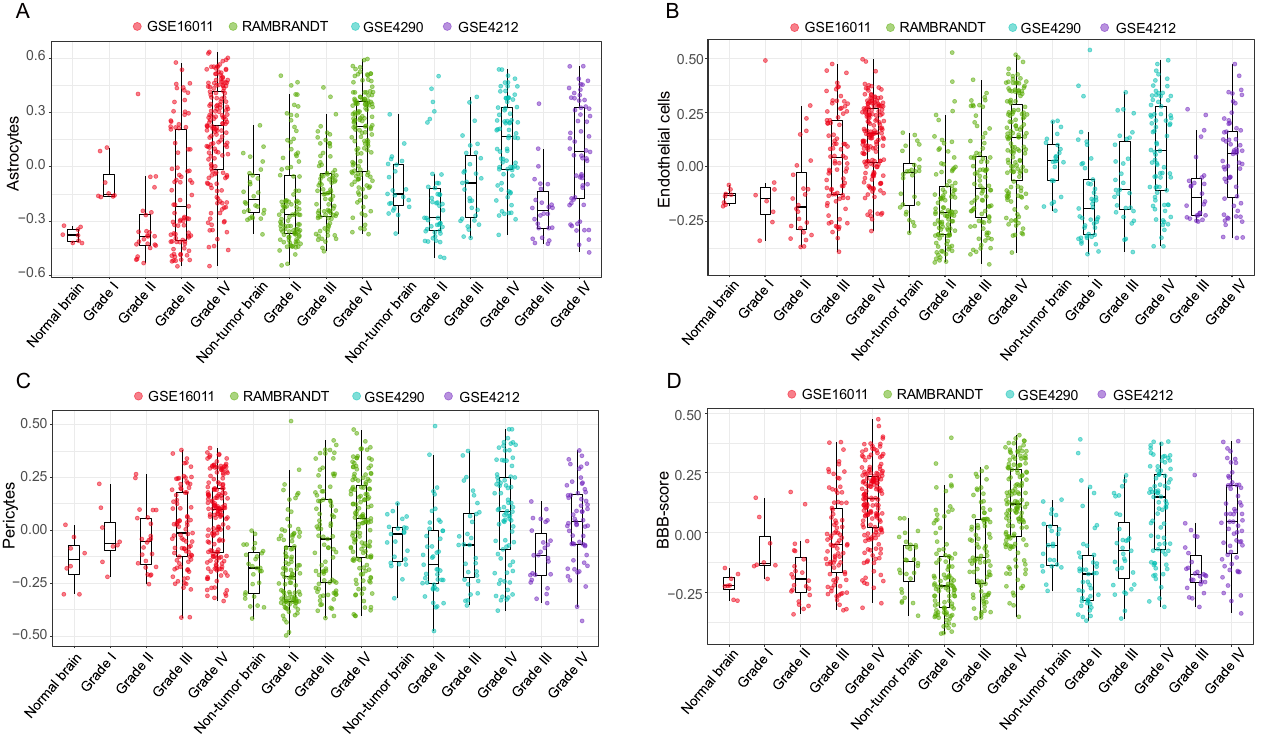
Figure 3. Distinct distribution of astrocytes ( A ), endothelial cells ( B ), pericytes ( C ) and BBB scores ( D ) according to glioma WHO grade in four independent cohorts.